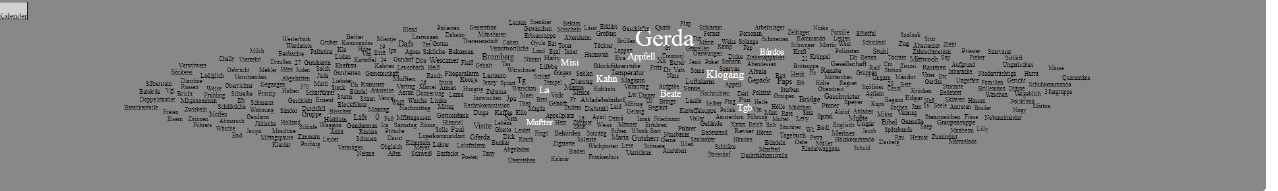
Figure 4. Tag cloud view over the entire year. This tag cloud aggregates data from all months of the year and shows tf-idf terms that are particularly important for that year as opposed to all years.